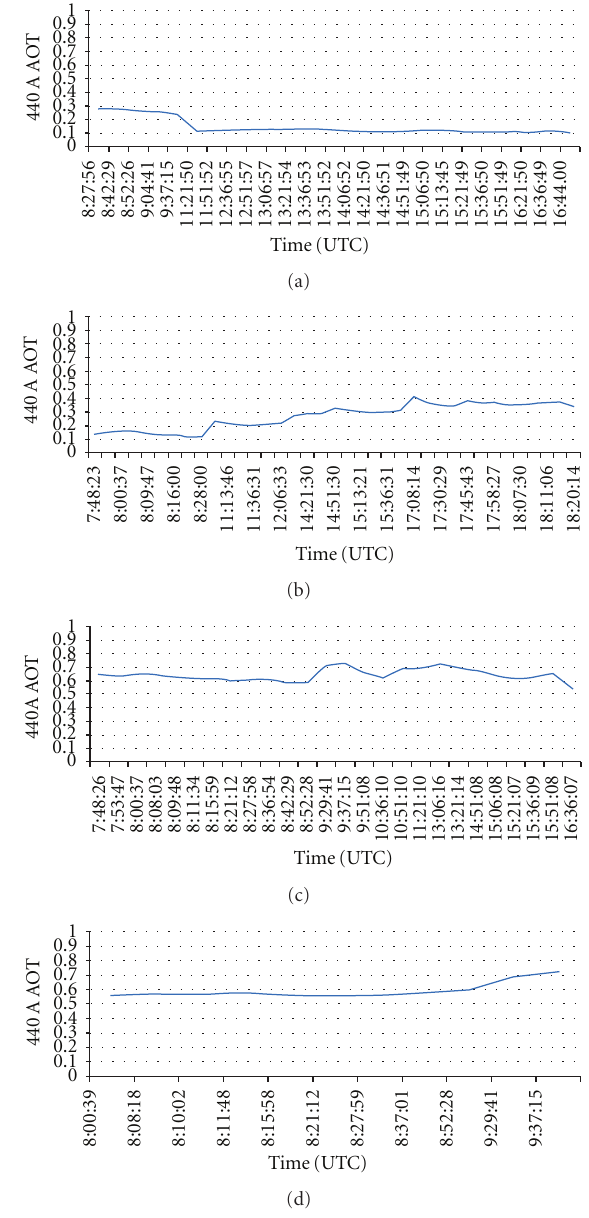
Figure 13: (a) A time series plot of 440 Angstrom AOT for 8 September 2006 at Mbour, Senegal. (b) A time series plot of 440 Angstrom AOT for 9 September 2006 at Mbour, Senegal. (c) A time series plot of 440 Angstrom AOT for 10 September 2006 at Mbour, Senegal. (d) A time series plot of 440 Angstrom AOT for 11 September 2006 at Mbour,